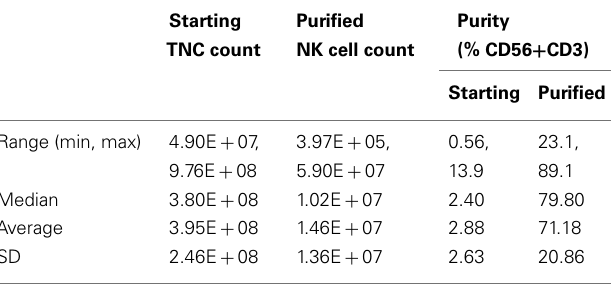
Table 1 | NK cell isolation from 30 cryopreserved Combo